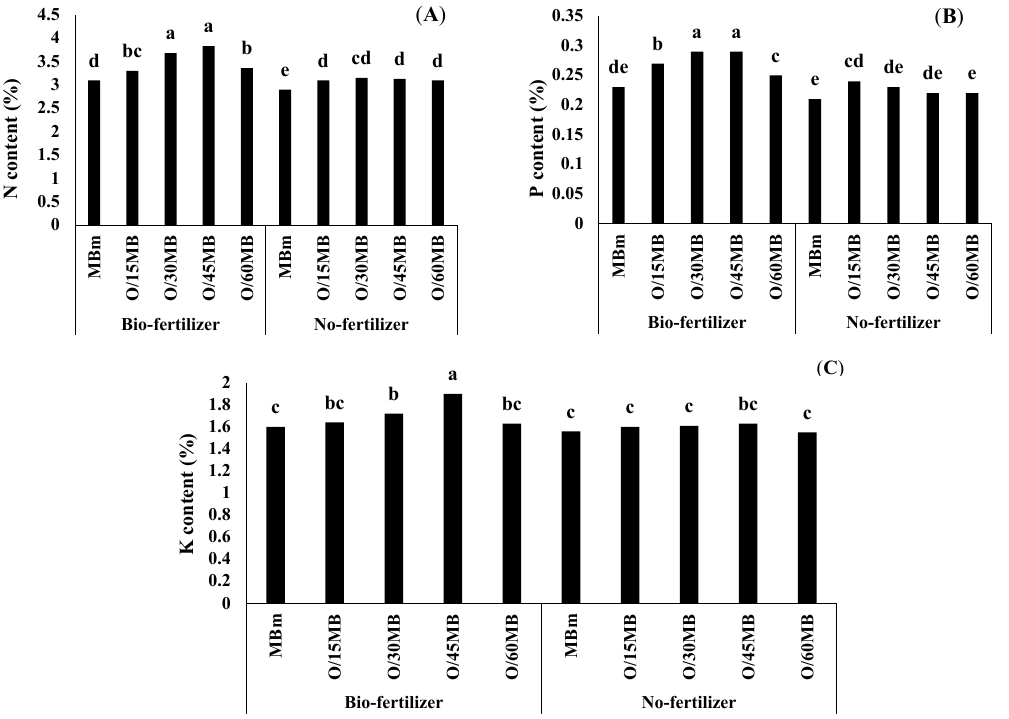
Figure 5. The content of N, P, and K under the interaction of cropping patterns and fertilizer application ( A – C ). MBm: mung bean monocropping; O/15MB: intercropping ratios of 100% marjoram + 15% mung bean; O/30MB: 100% marjoram + 30% mung bean; O/45MB: 100% marjoram + 45% mung bean; O/60MB: 100% marjoram + 60% mung bean. Different lower ‐ case letters above the bars indicate significant ( p ≤ 0.05) differences.